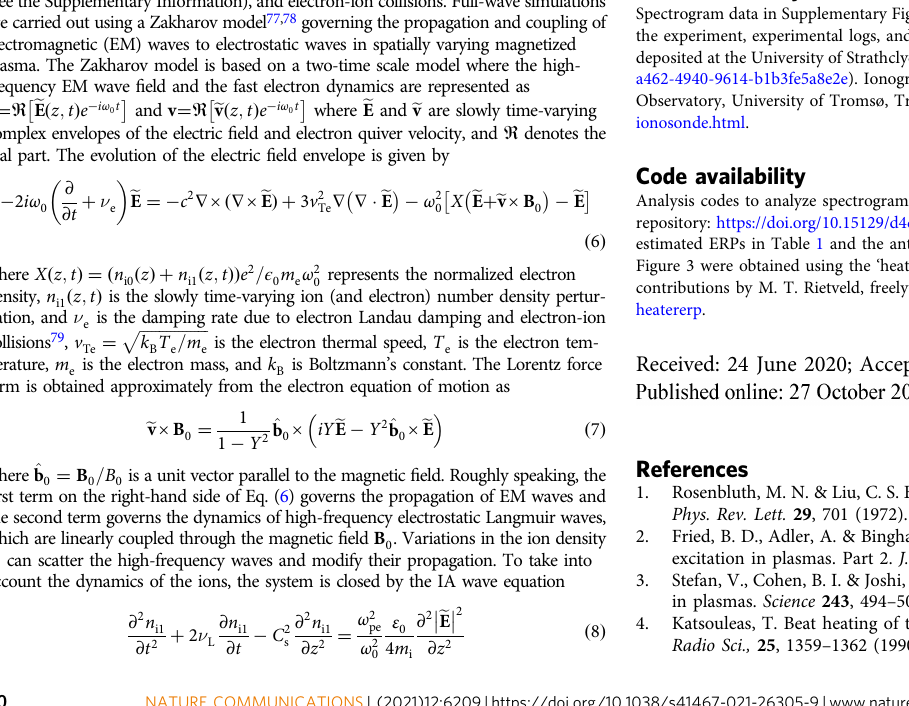
Fig. 4e, while the electron Landau damping in ν e is approximated with a diffusion operator 79 . The EM waves are injected at the bottom boundary to propagate into the plasma, while downward propagating waves are absorbed at the bottom boundary via an out fl ow boundary condition. Calculation of spectrograms . The experimental spectrograms in Fig. 2 (and Supplementary Figures 7 – 9) and simulated spectrograms in Fig. 7 are obtained by